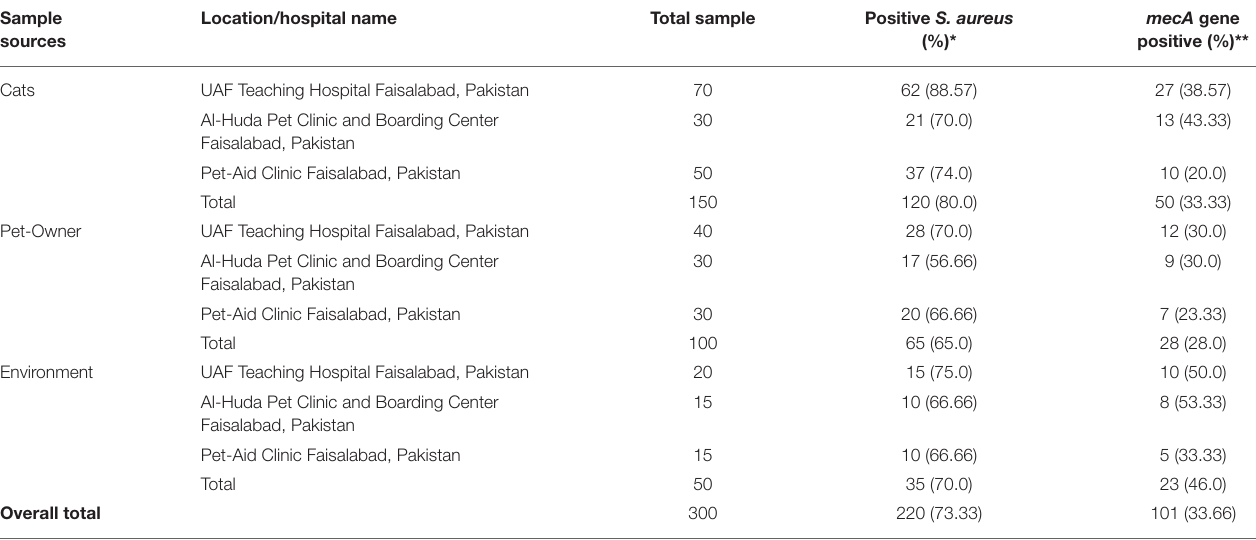
TABLE 2 | Infection status of methicillin resistance Staphylococcus aureus ( mecA gene) isolates. Sample sources